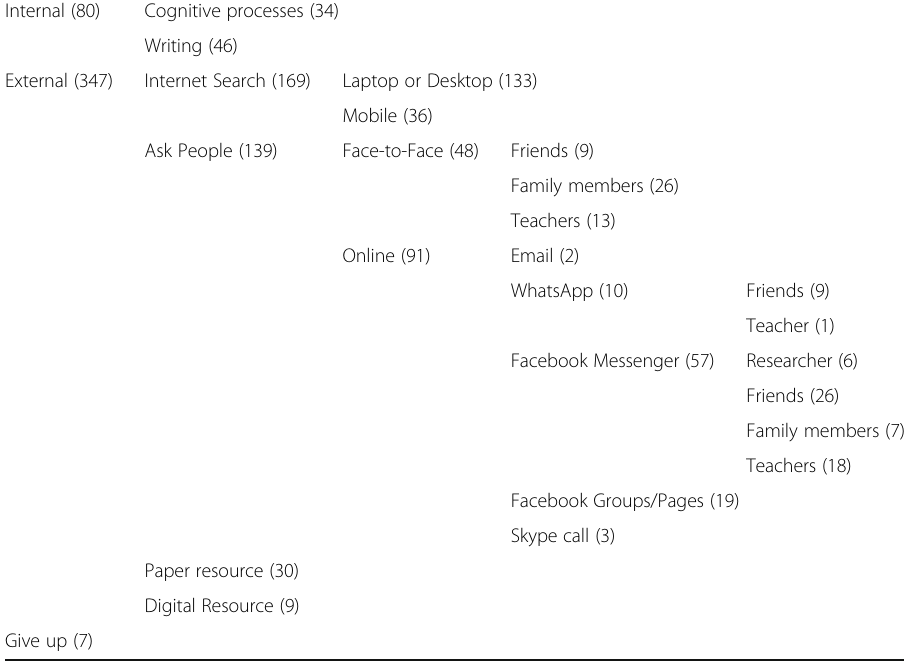
Table 2 Learning nodes